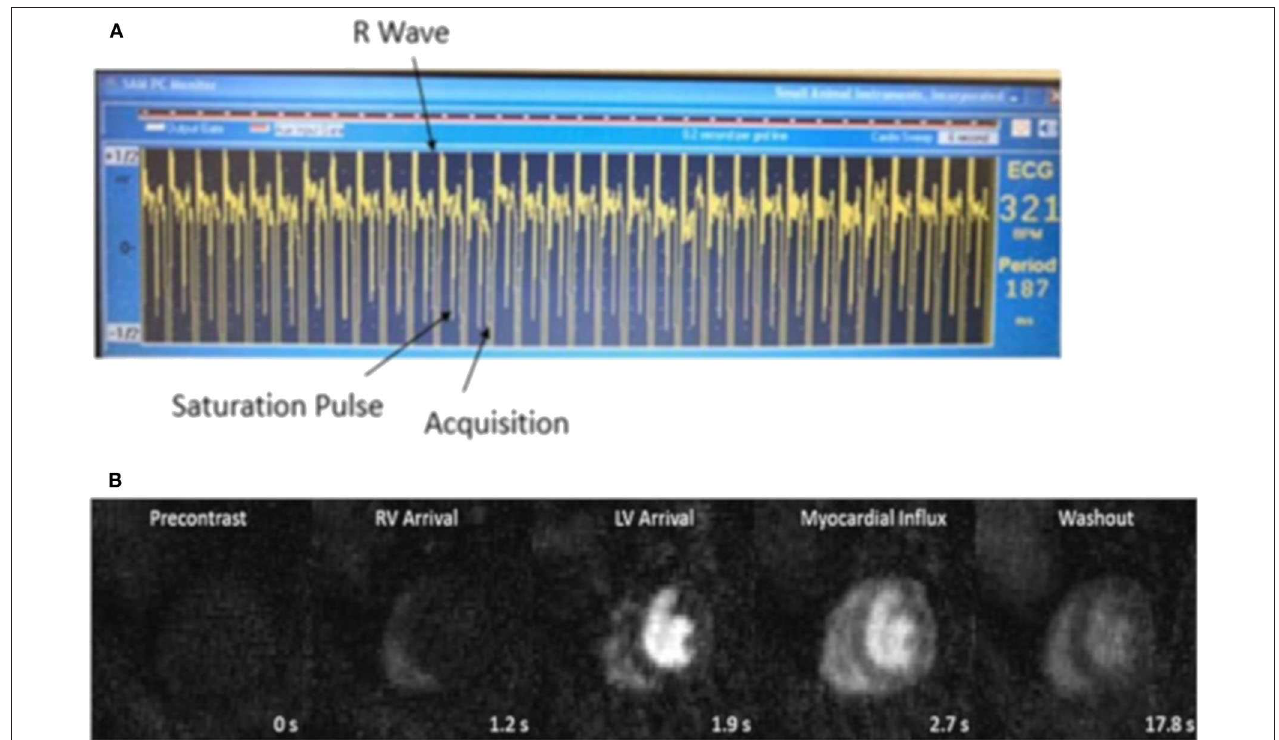
FIGURE 7 | (A) ECG signal during scan. According to the heart rate, a trigger delay was set after the detection of the R wave, then the blood and myocardial signal were approximately nulled by a non-selective saturation pulse. The acquisition was performed during end-diastole. (B) Time series of myocardial first-pass perfusion images of a nexilin wild-type mouse. From left to right: precontrast, RV arrival, LV arrival, myocardial influx, and